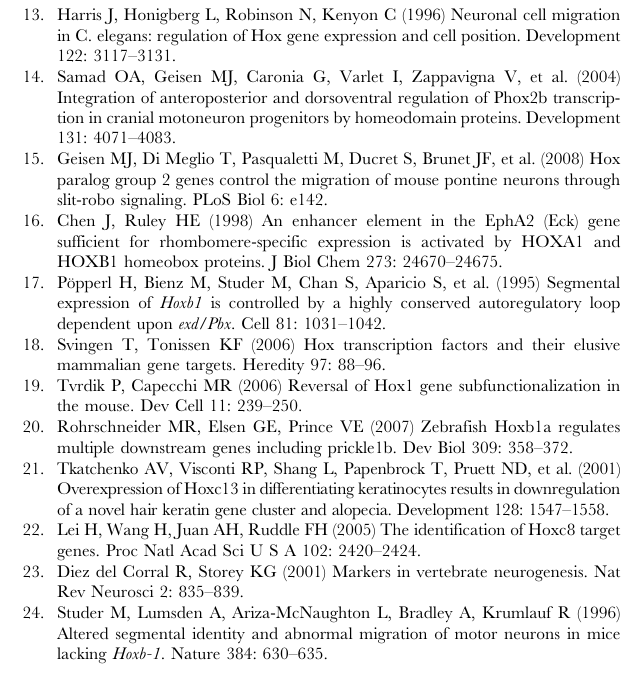
Table S1 List of genes regulated by Hoxb1 induction in the long induction scheme as found by microarray gene expression profiling. Table S2 List of genes regulated in both short (s) and long (l) induction schemes. Classification is according to primary GO process assignment. If not an assignment has been made genes are labelled as non-classified. Table S3 List of of common genes induced in Hoxb1-/- r4 and also regulated by Hoxb1 in ES derived neural progenitors after long induction. At the top part of the list the observed regulation is in the same direction and after the space it is in the opposite direction. Table S4 List of common genes repressed in Hoxb1-/- r4 and also regulated in ES derived neural progenitors after long induction. At the top part of the list the observed regulation is at the same direction and after the space it is in the opposite